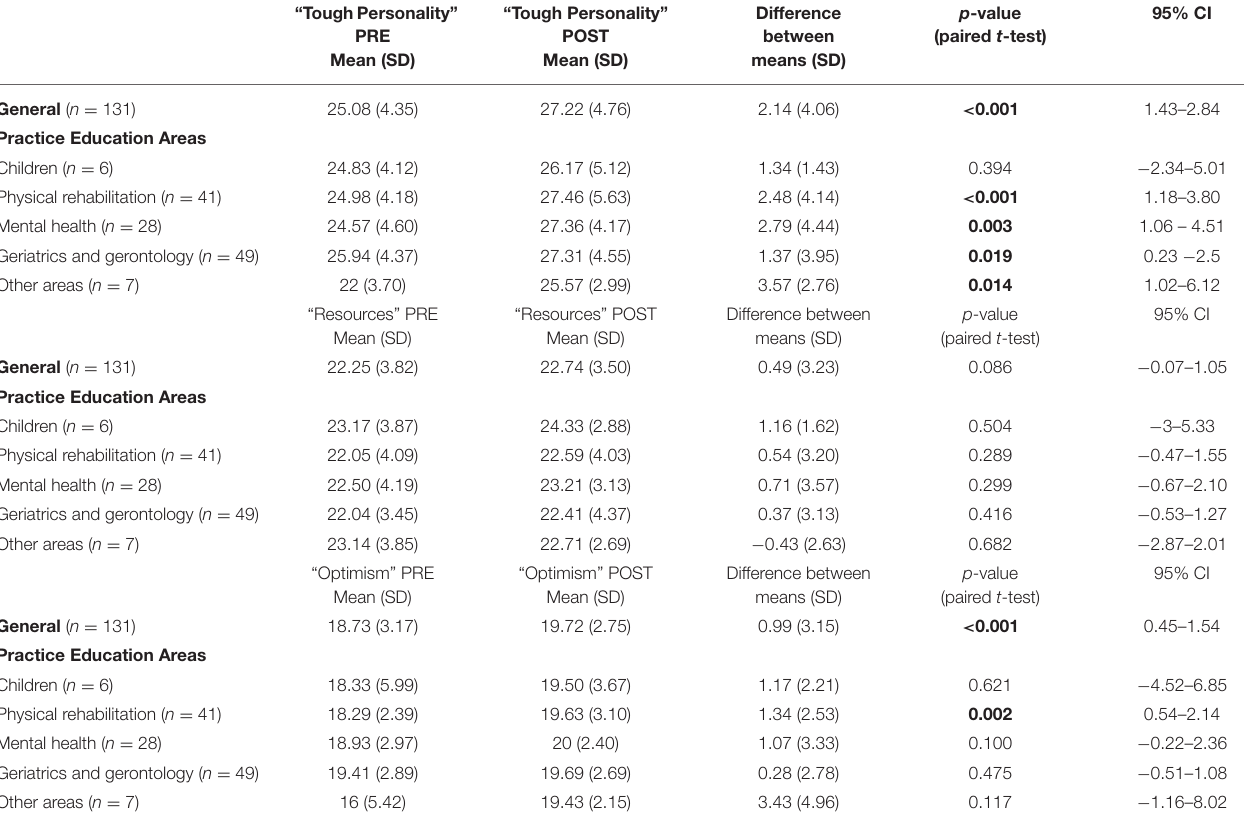
TABLE 5 | Practical training PRE-POST scores of dimensions “Tough Personality,” “Resources,” and “Optimism” (CD-RISC 25) in female students ( n = 131). “ToughPersonality” “Tough Personality” PRE Mean (SD)